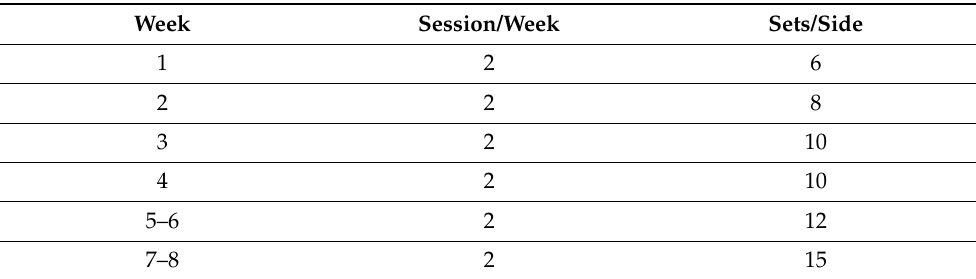
Table 1. Progression in training based on Copenhagen adduction